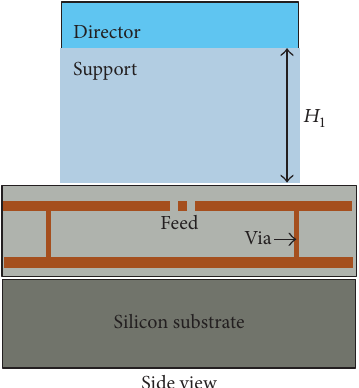
Figure 30: Side view of the suggested on-chip antenna as presented in [72].